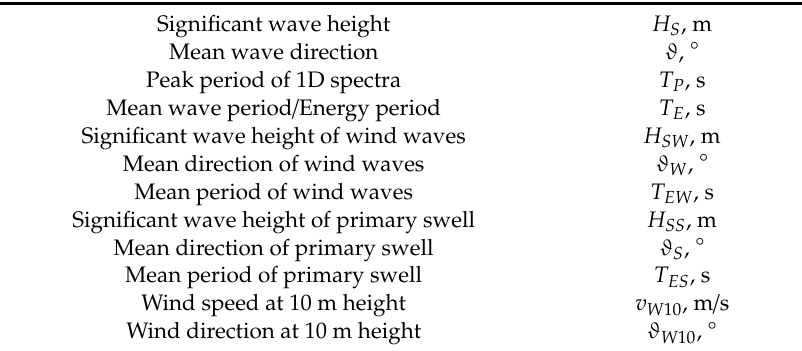
Table A1. WWA wave and wind parameters.